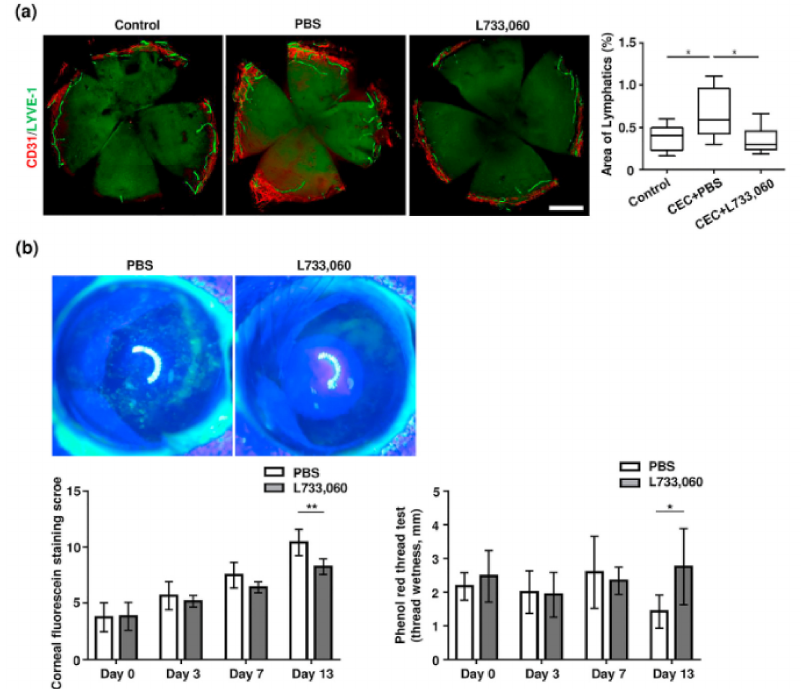
Figure 2. NK1R blockade ameliorates pathological corneal lymphangiogenesis and improves clinical signs of dry eye in vivo. (a) Representative immunofluorescence images of whole-mount cornea stained with CD31 (red) and LYVE-1 (green) and quantification of the percentage of lymphatics area covered with LYVE-1 in the cornea tissue at 14 days after induction of dry eye in CEC. NK1R antagonist (L733,060, 6.6 µ g/5 µ L) for the DED treatment group or same volume of PBS for PBS group was administered through subconjunctival injection every 48 h to 72 h from day 0 to day 14 of DED induction by CEC. Each value represents the mean ± SEM of nine independent whole-mount cornea. * p < 0.05 by Mann-Whitney U test. Scale bar = 500 µ m. (b) Representative corneal fluorescein staining images showing punctate epithelial erosion at 14 days after induction of dry eye in CEC. Quantification of corneal fluorescein staining scoring according to the standard National Eye Institute grading system (Bethesda, MD) and the amount of tears measured by the phenol red thread test. * p < 0.05, ** p < 0.01 by Mann-Whitney U test. n = 6. CEC: controlled environmental chamber, LYVE-1: lymphatic vessel endothelial hyaluronan receptor 1, NK1R: neurokinin-1 receptor, PBS: phosphate-buffered saline